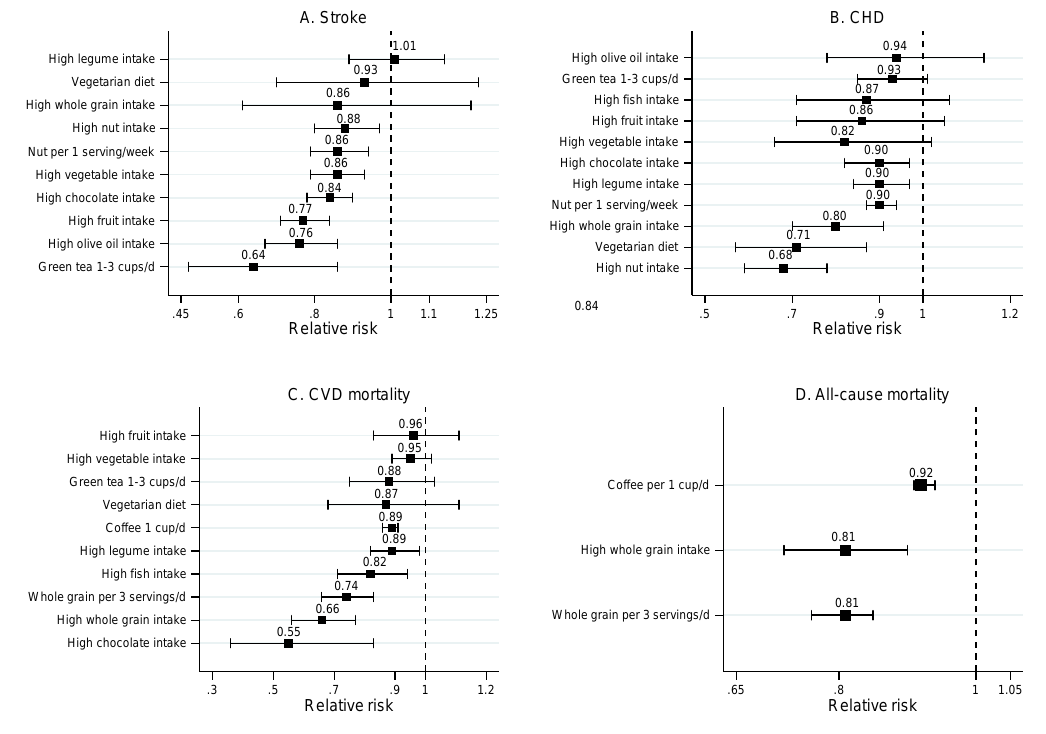
Figure 3. Pooled risk ratios of food groups and risk of stroke ( A ), coronary heart disease ( B ), cardiovascular mortality ( C ), and all-cause mortality( D ). Results are from systematic reviews and meta-analyses of observational studies. (CHD, coronary heart